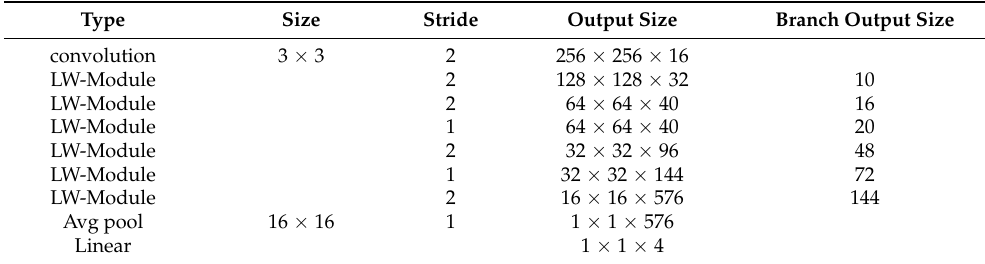
Table 4. Architecture of WTBMobileNet.